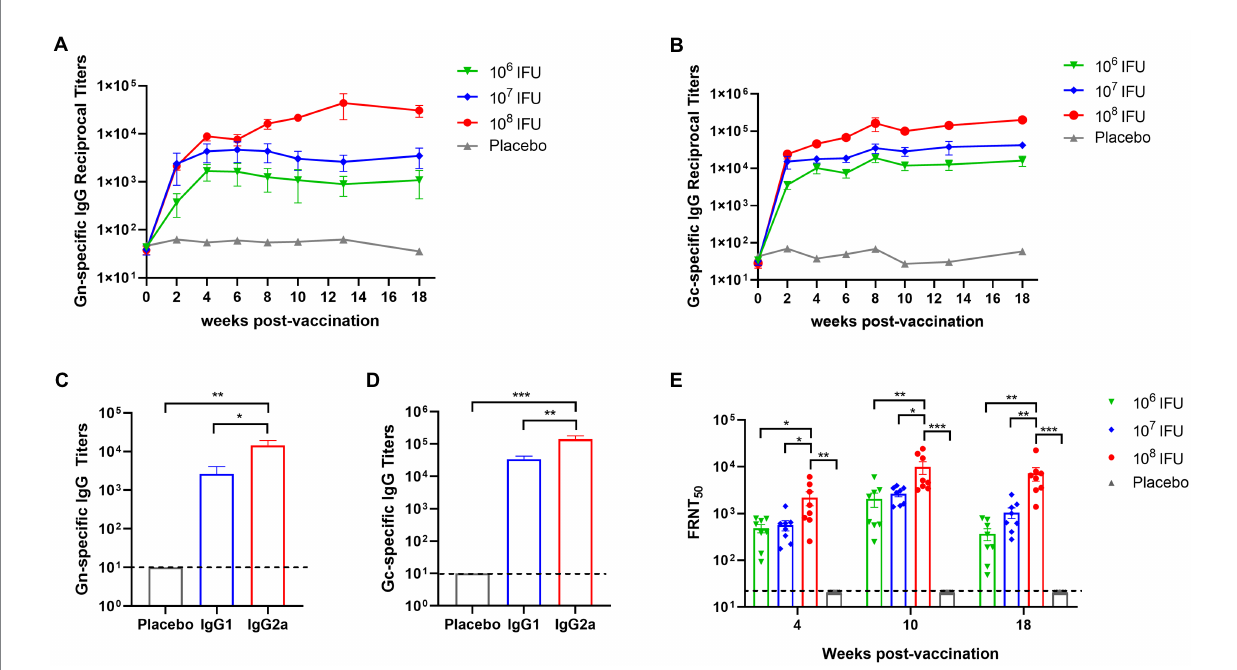
FIGURE 2 Durable humoral immune response elicited by Ad5-GnGcopt in BALB/c mice. BALB/c mice ( n = 8) were intramuscularly immunized with a single dose of Ad5-GnGcopt (10 6 , 10 7 , or 10 8 IFU) or placebo. Sera were collected at 2, 4, 6, 8, 10, 13, and 18 weeks after vaccination. RVFV (A) Gn- and (B) Gc- specific IgG antibody titer was determined by ELISA. (C,D) Sera from the high-dose group collected on day 28 after immunization determined (C) Gn- and (D) Gc-specific IgG subclasses. (E) Serum samples collected 4, 10, and 18 weeks after vaccination were subjected to neutralizing antibody titers detection. Data are indicated as mean ± SEM. One-way ANOVA with multiple comparison tests calculated p values. * p < 0.05, ** p < 0.01, *** p <